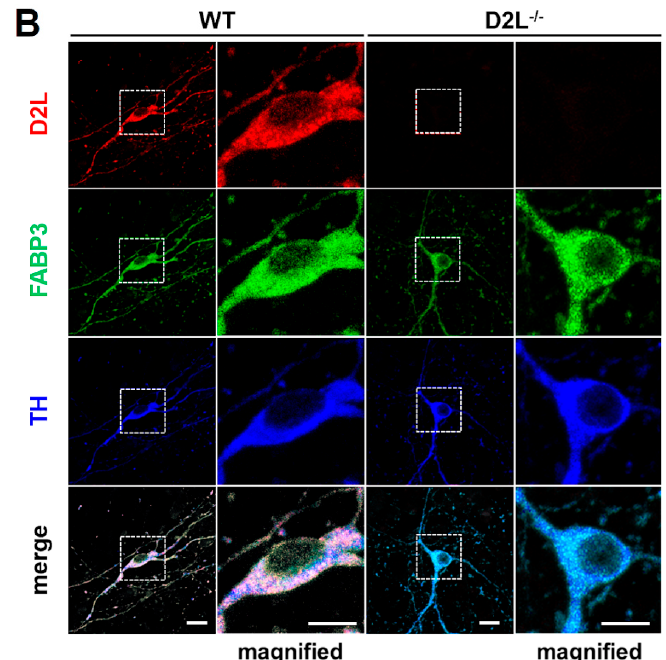
Figure 2. Distribution of dopamine D2 long (D 2L ) receptors and their co-localization with FABP3 in dopaminergic neurons. ( A ) Cultured mesencephalic neurons were stained with anti-D 2L -specific (red) and anti-tyrosine hydroxylase) (TH (green) antibodies. No D 2L signal was observed in D 2L − / − neurons. Right images in each group were magnified by three times. Scale bar 10 μ m. ( B ) Cultured mesencephalic neurons were counterstained with anti-D 2L -specific (red), anti-FABP3 (green), and anti-TH (red) antibodies. D 2L and FABP3 were co-distributed. Right images in each group were magnified by 2.5 times. Scale bar 10 μ m.